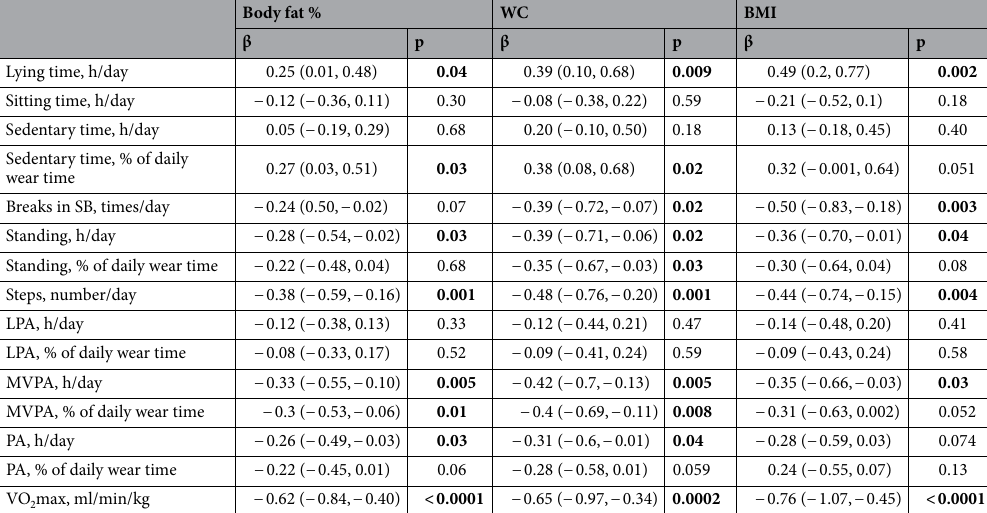
Table 3. Age -and sex -adjusted linear mixed regression estimates (standardized β coefficients (95% CI)) between body composition, sedentary behavior, physical activity and fitness. BMI body mass index, LPA light physical activity; MVPA moderate-to-vigorous physical activity, PA physical activity (LPA and MVPA together), SB sedentary behaviour (sitting + lying), VO 2max maximal oxygen consumption, WC waist circumference. Significant values are in bold.